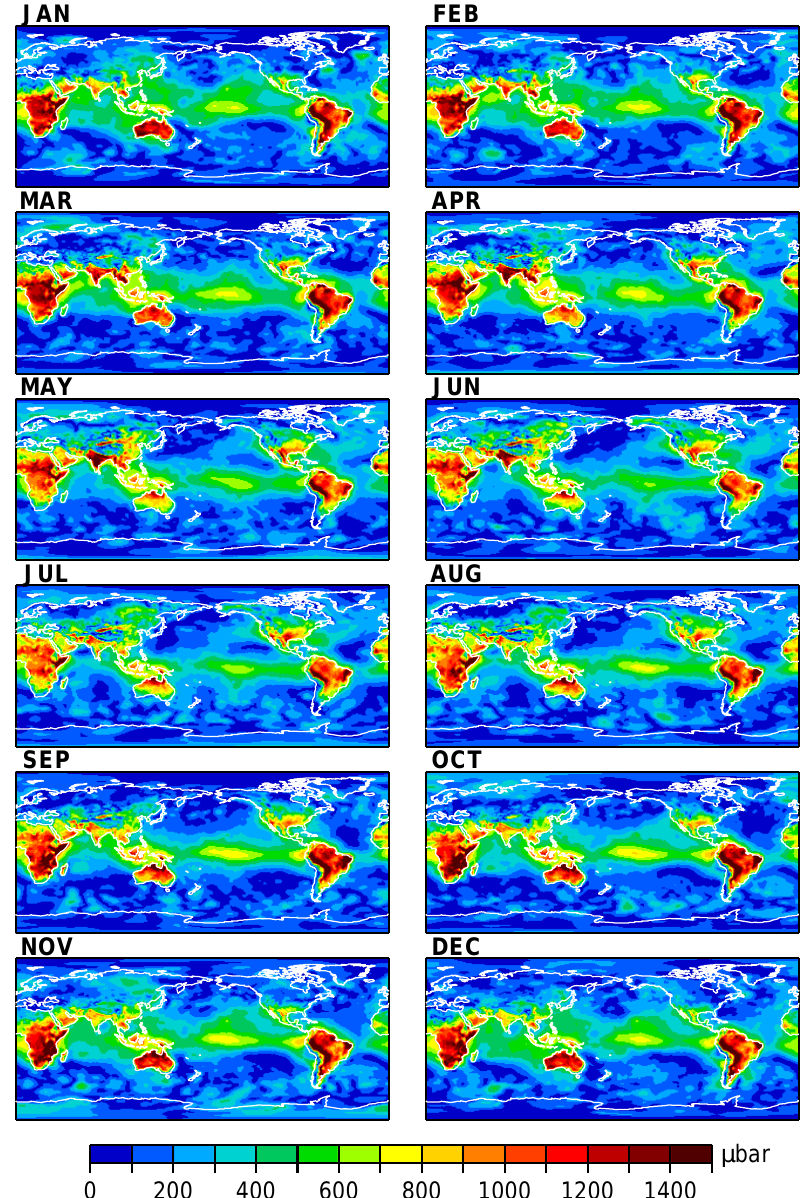
Fig. 10. Monthly mean amplitude of the S 1 (p) tide as deduced from ECMWF surface